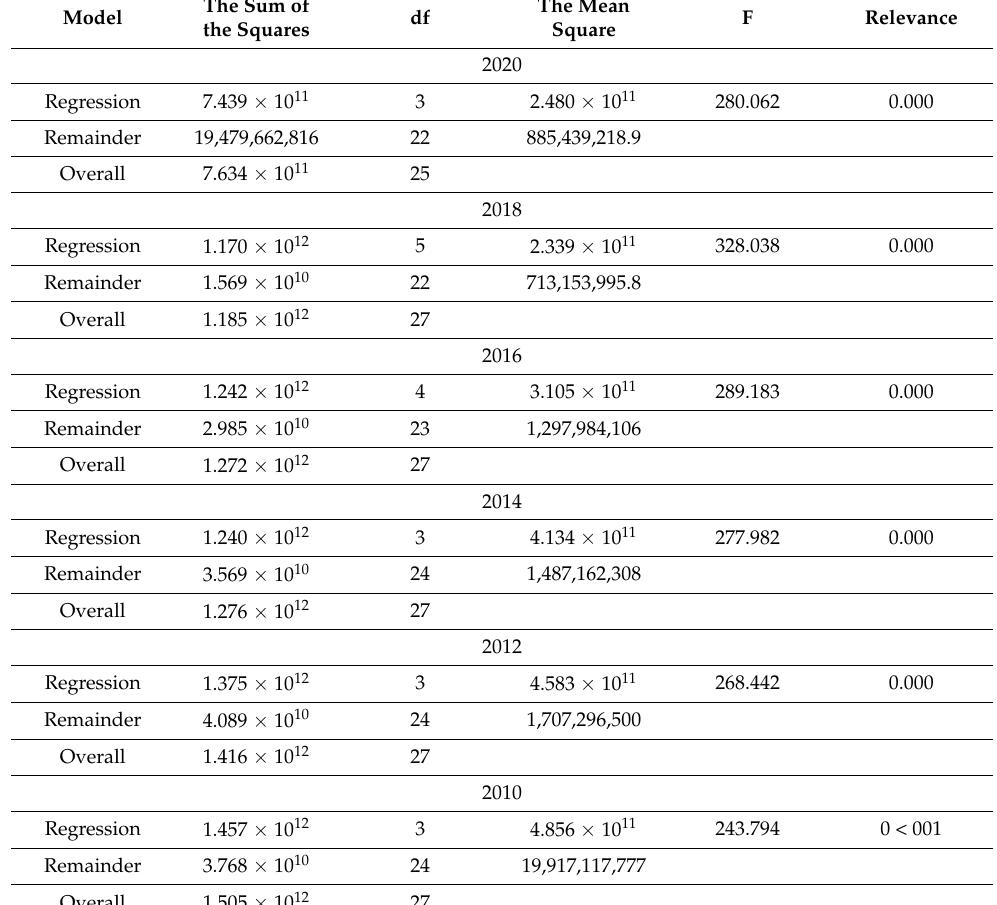
Table 5. Analysis of variance (ANOVA).